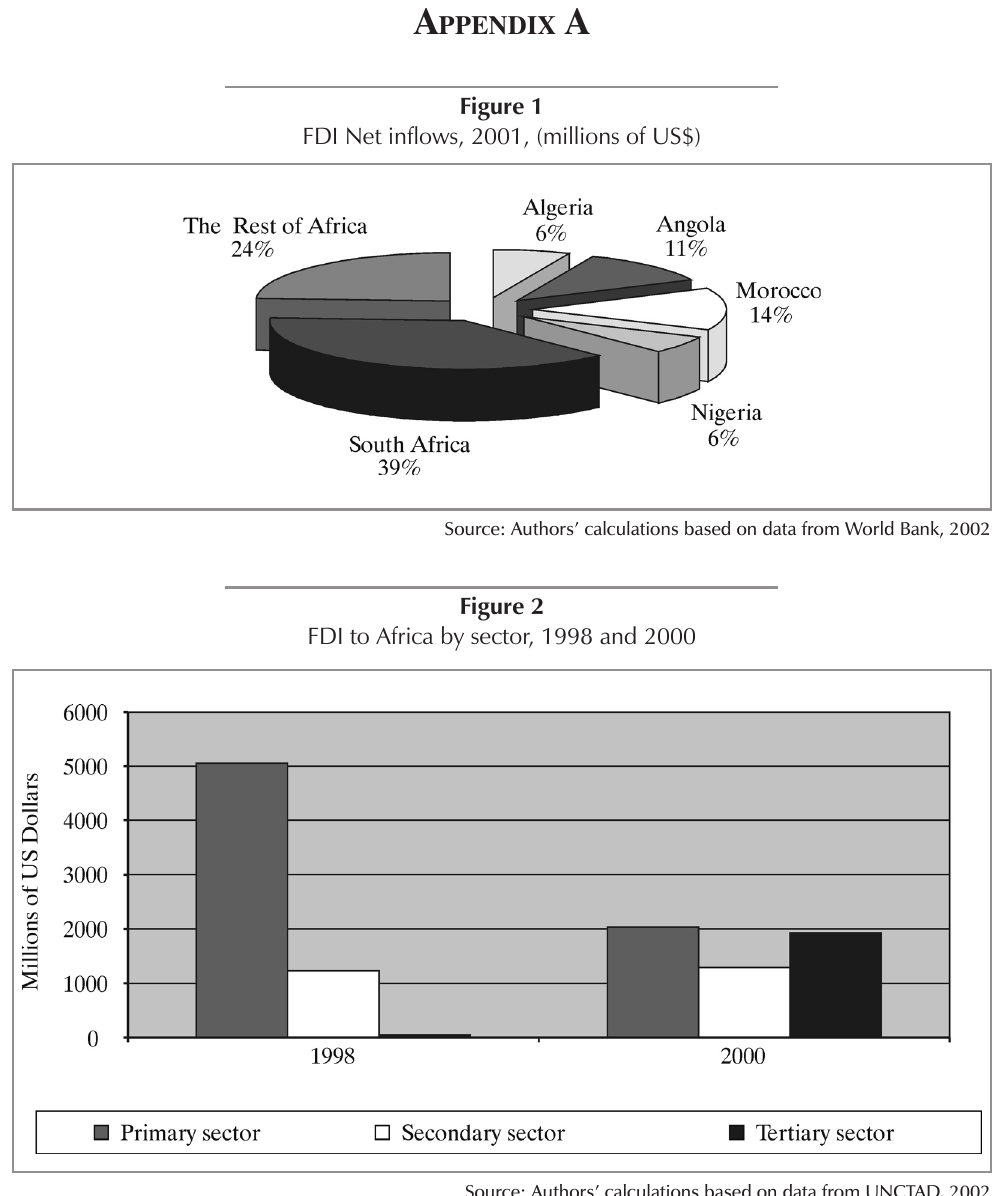
Source: Authors’ calculations based on data from UNCTAD,